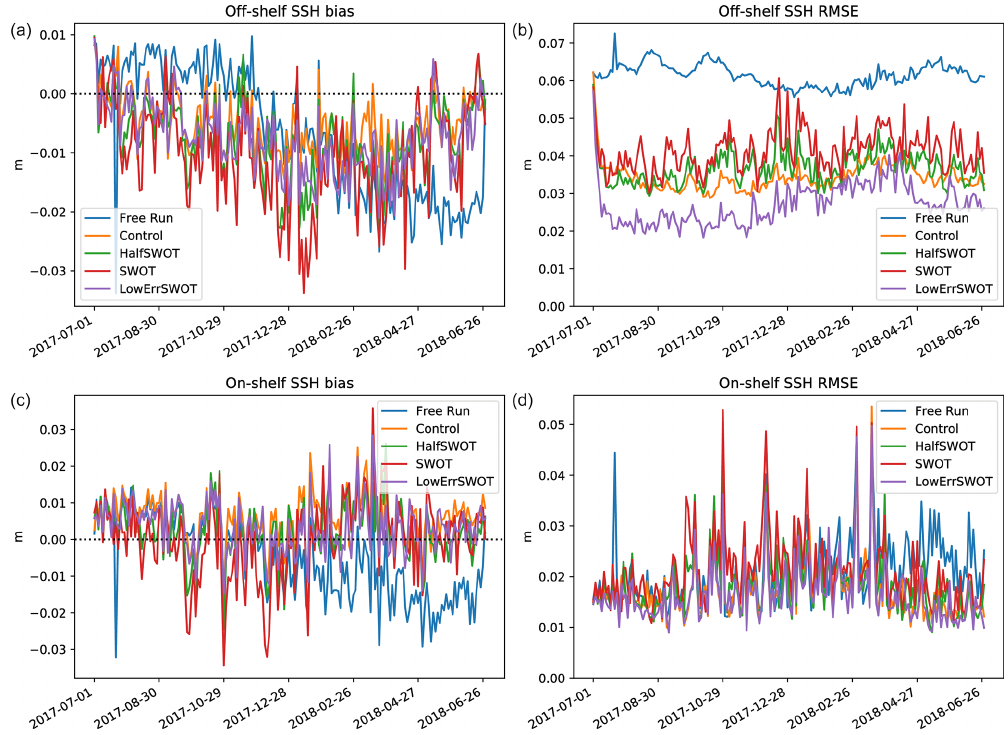
Figure 7. SSH bias (m, a,c ) and RMSE (b,d) for the off-shelf (a,b) and on-shelf (c,d)